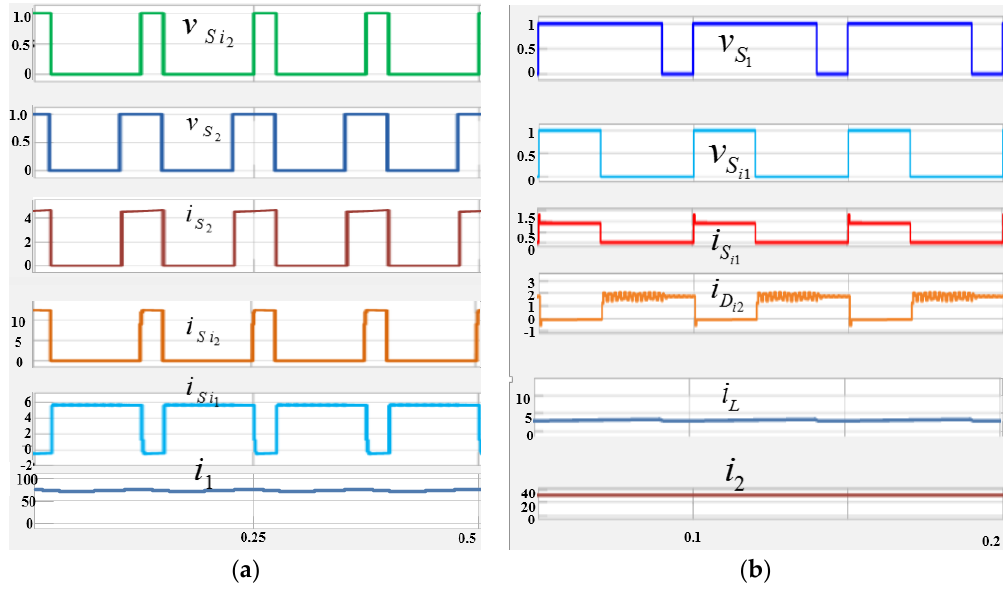
Figure 12. Simulation results for the converter under isolated mode: ( a ) the forward converter under isolated mode; and ( b ) the isolated high conversion-ratio operation mode.